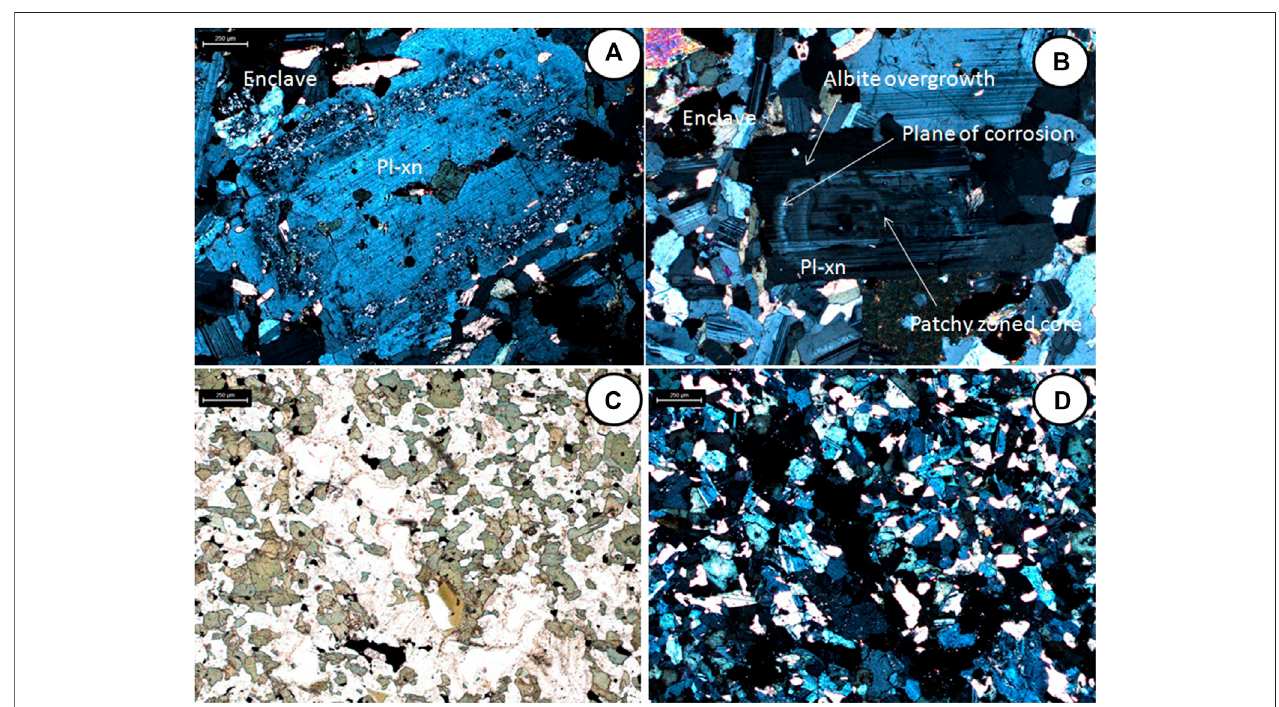
FIGURE9|(A) Plagioclasexenocryst(Pl-xn)intheporphyritic(hybrid)enclave.Notethesericitizationalongtheplaneofcorrosionshownbyawhitearrow.Crossed polar. (B) Plagioclase xenocryst (Pl-xn) in porphyritic (hybrid) enclave showing patchy zoned core, corroded margin with the growth of An-rich plagioclase (bright gray) and albite rim. Crossed polar. The base of the photograph equals 2.5 mm. (C) Predominating amphibole and subordinate biotite show subpoikilitic relation with plagioclaselathsinma fi csynplutonic dyke.Note thequartzrindsinthecentersurrounded byminutedustyma fi cgrains. Plane Polarized. (D) Crossedpolarviewof the same as (C) . The base of the photograph equals 2.5